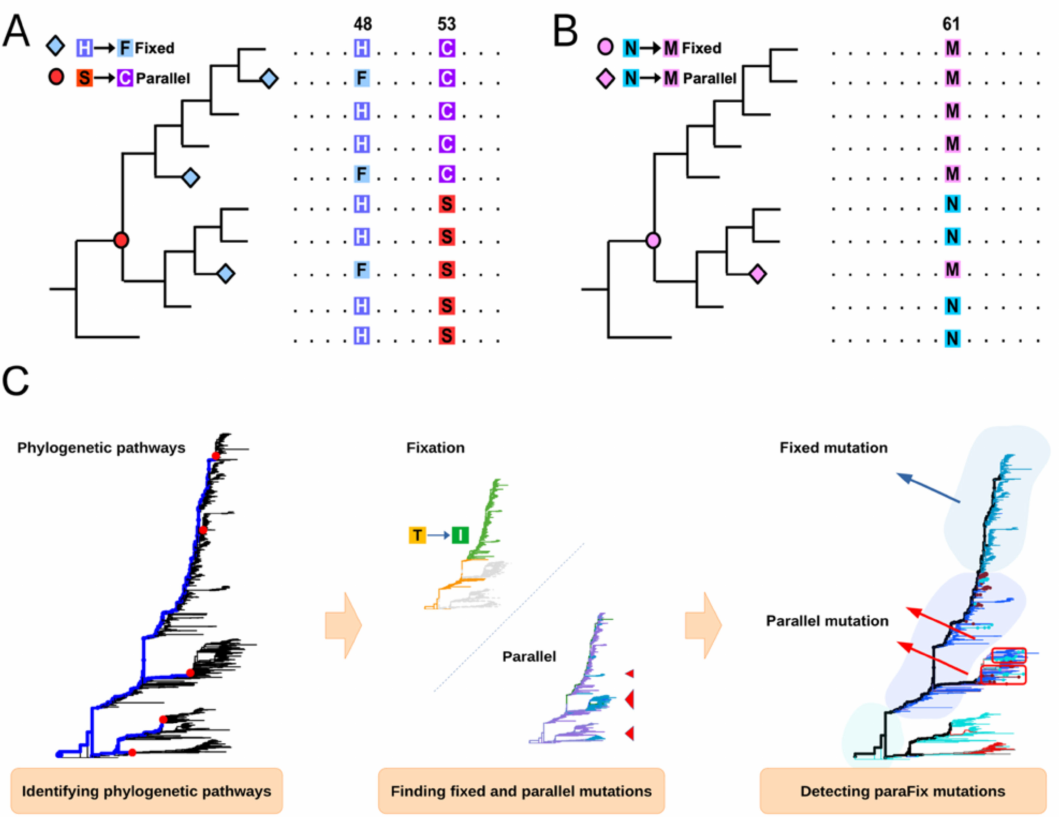
Figure 1. Identification of parallel or/and fixed mutations. ( A ) Fixed mutations refer to the de novo mutations that are fixed in a viral population; for instance, the mutation S → C. Parallel mutations refer to the mutations that appear independently in different phylogenetic pathways; for instance, the parallel mutations H → F appeared in independent phylogenetic pathways. ( B ) The paraFix mutation should have both the fixed and parallel pattern in the phylogenetic tree, similarly to the mutation of N → M. ( C ) Workflow of mutation identification in sitePath tool. Three major steps are included: the phylogenetic pathways are identified (Figure in left, the phylogenetic pathway was labeled blue); the fixed mutations are detected, along each phylogenetic pathway, and the parallel mutations are detected among different phylogenetic pathways (Figure in middle, the tree tips with the same type of amino acid were colored the same); and finally, the paraFix mutations are detected by integrating the fixed and parallel patterns (Figure in the